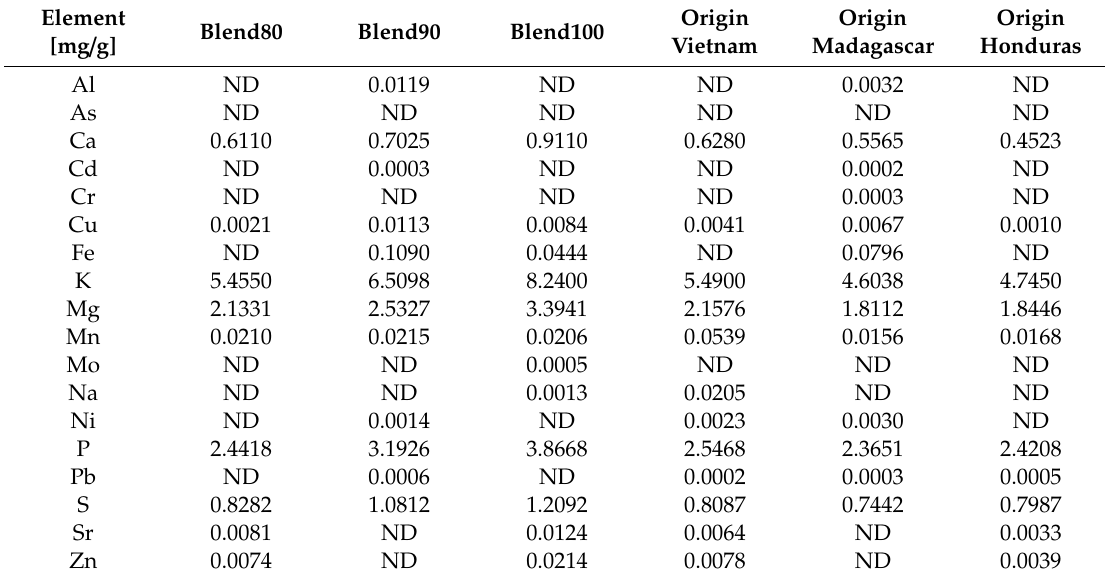
Table 3. The mineral composition of